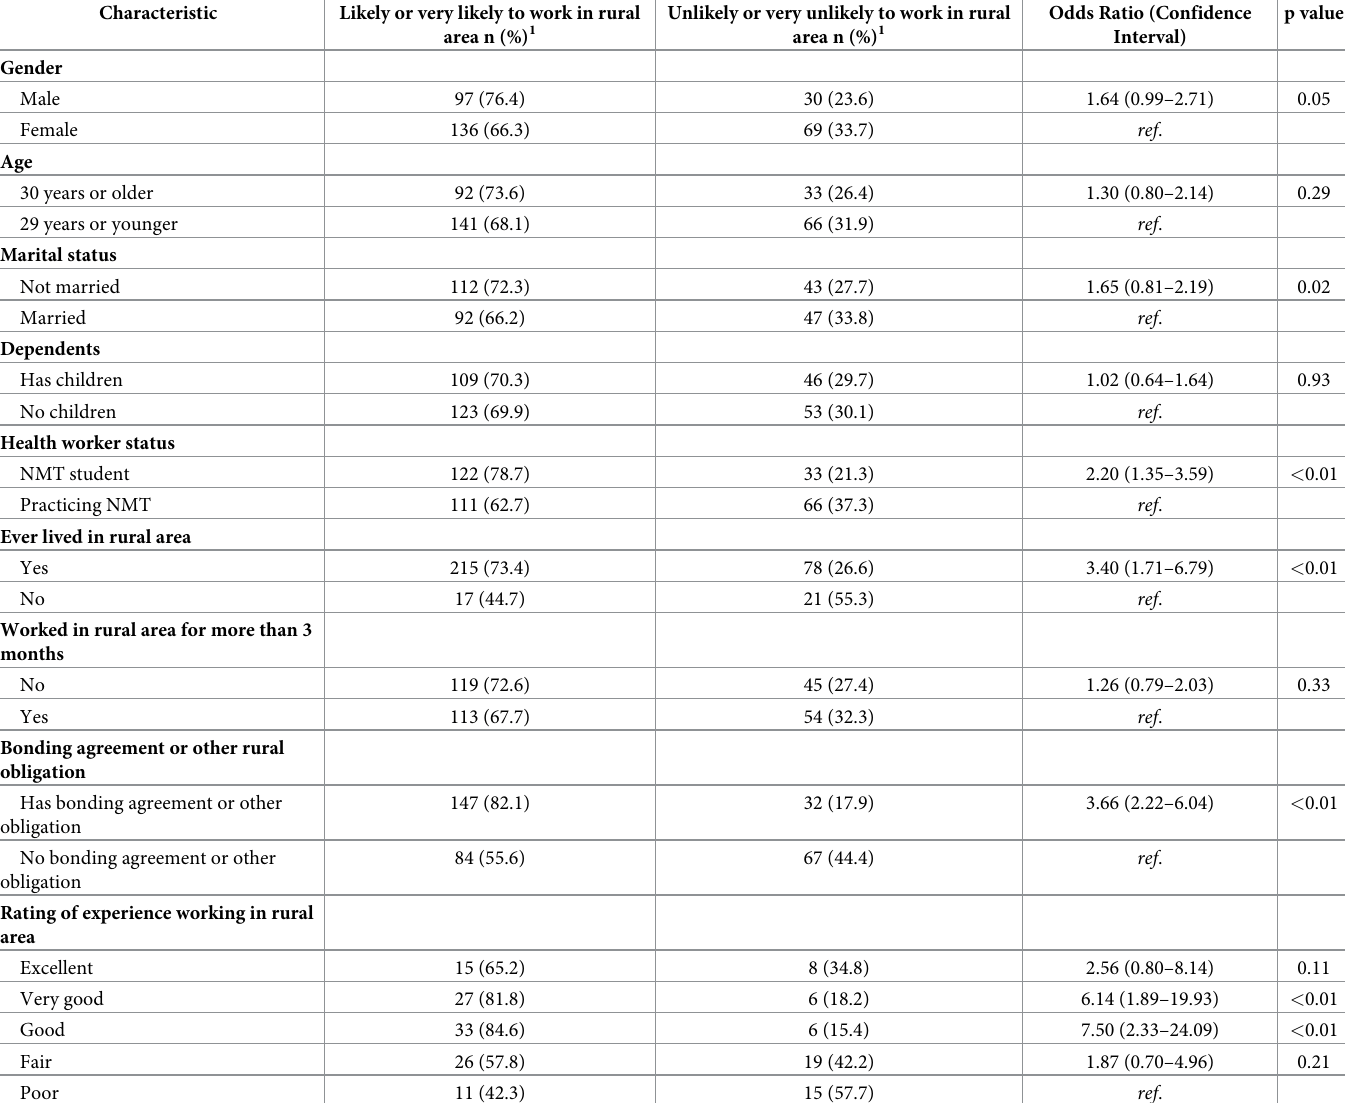
Table 3. Association between likelihood of working in a rural area and participant